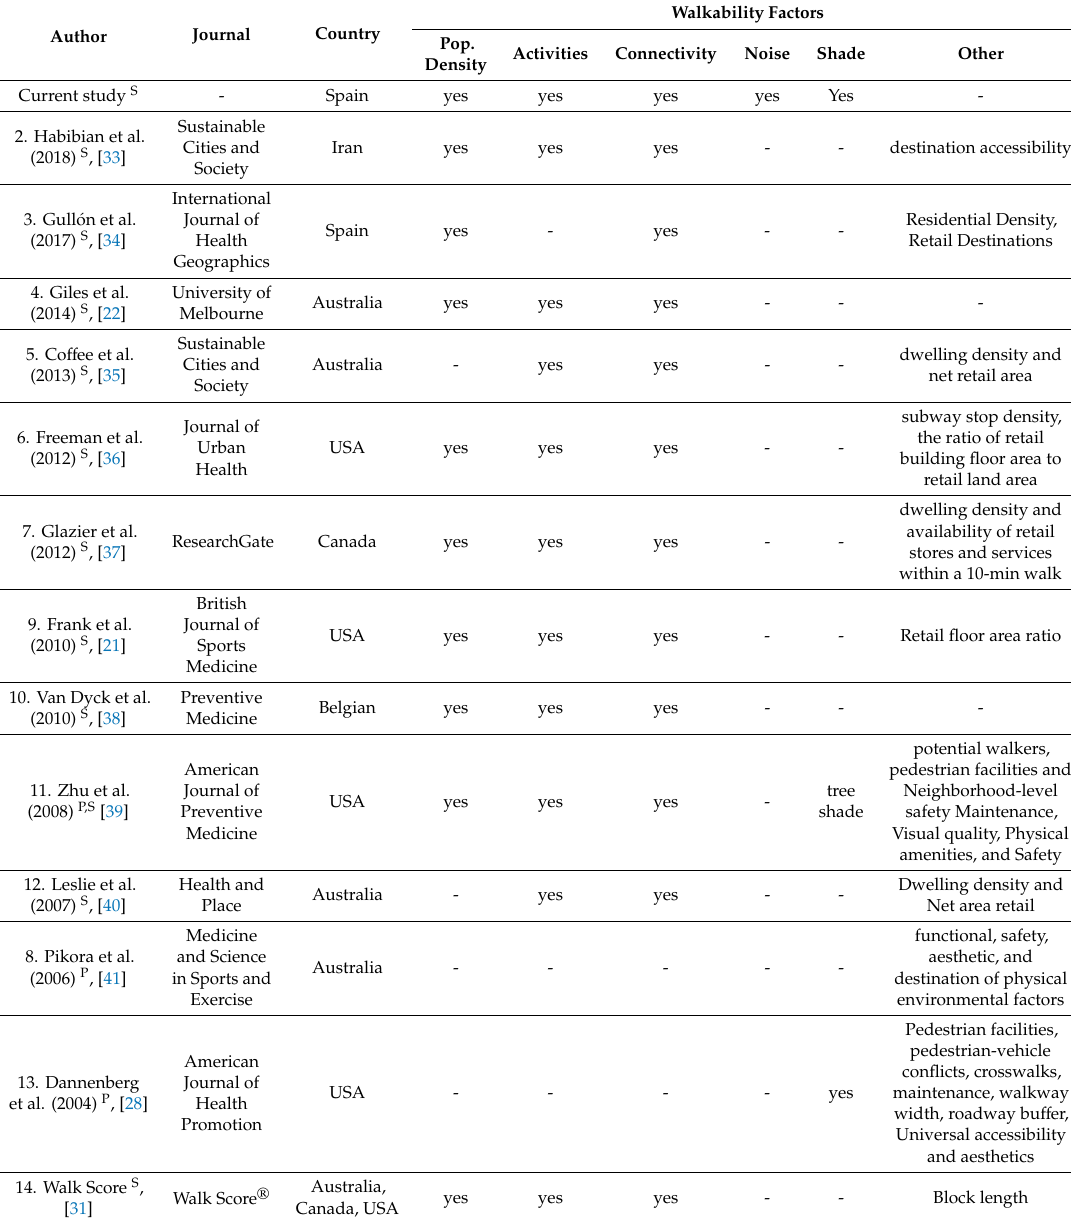
Table 1. Factors and data types in di ff erent walkability indices (WI) around the